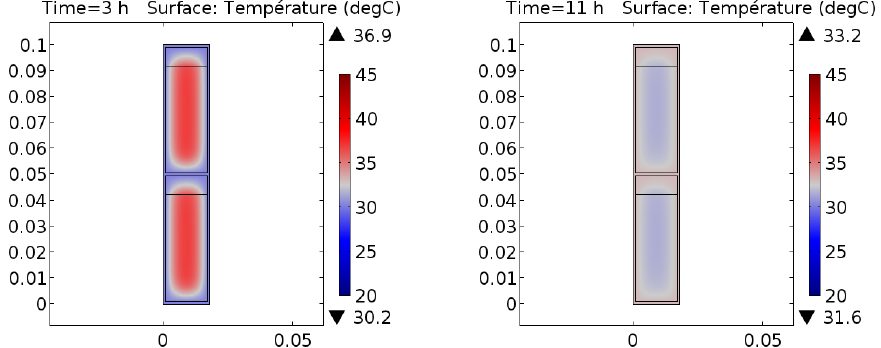
Figure 13. Internal distribution of temperatures predicted by the 2D model at two instances in the trial: 3 h after the start time, when the PCM is solidifying; and 11 h after the start when the PCM is